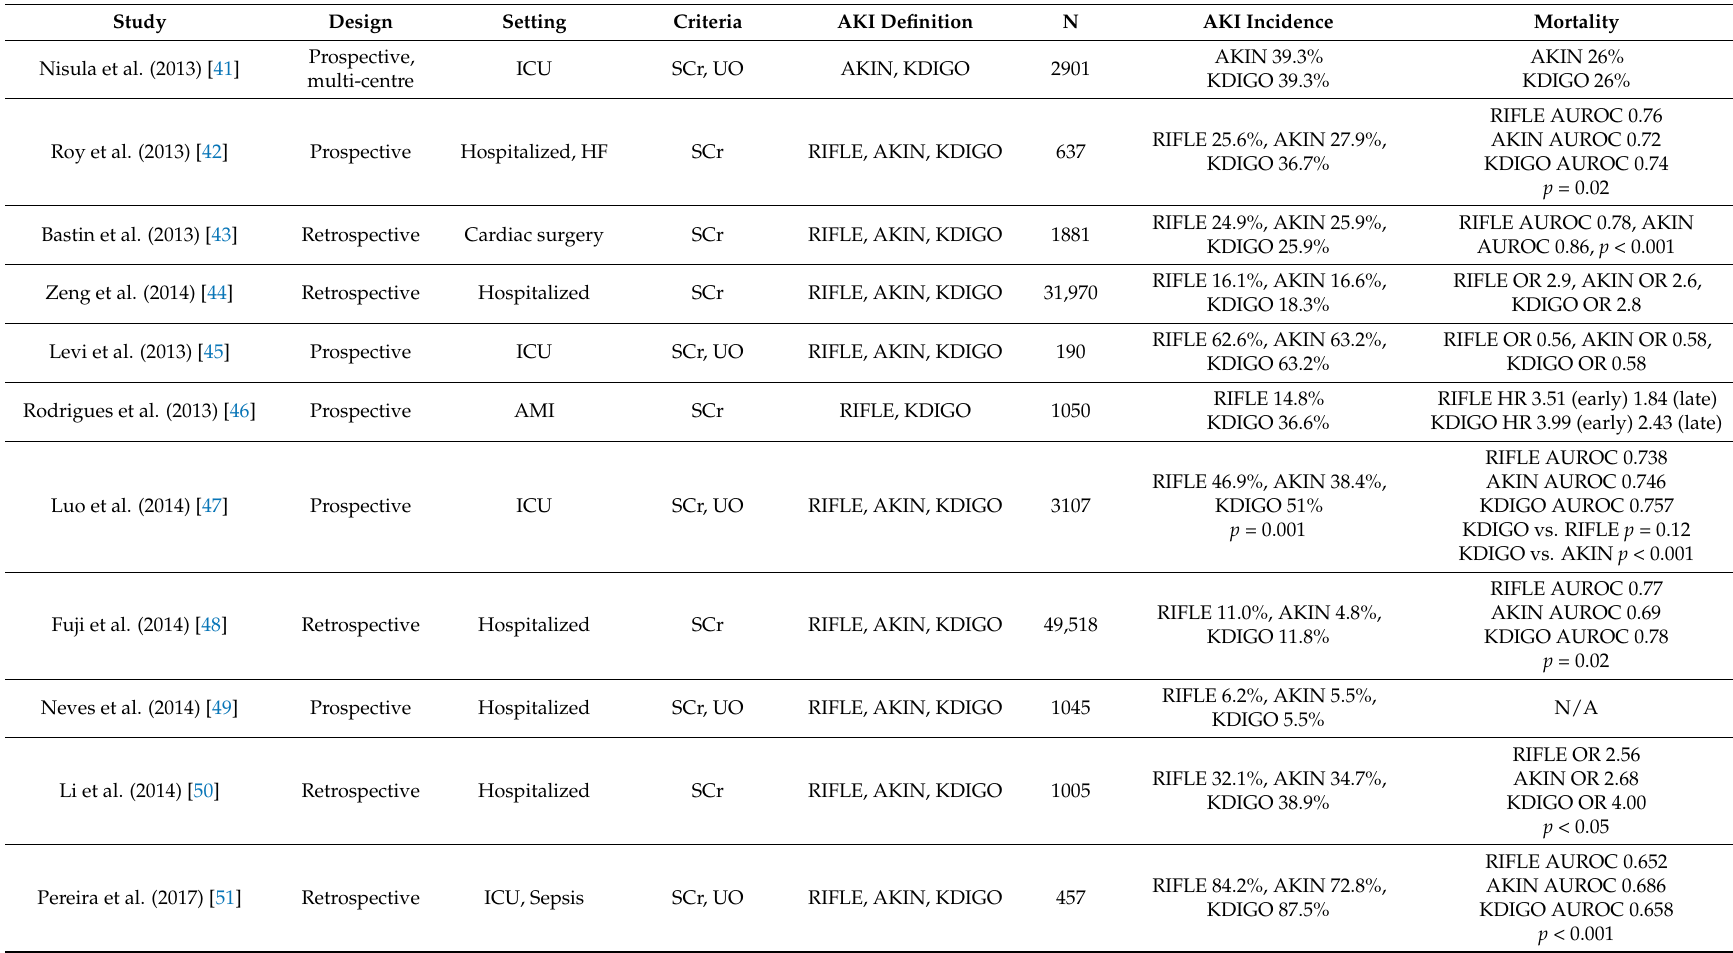
Table 2. Incidence of AKI and patient outcomes according to AKI